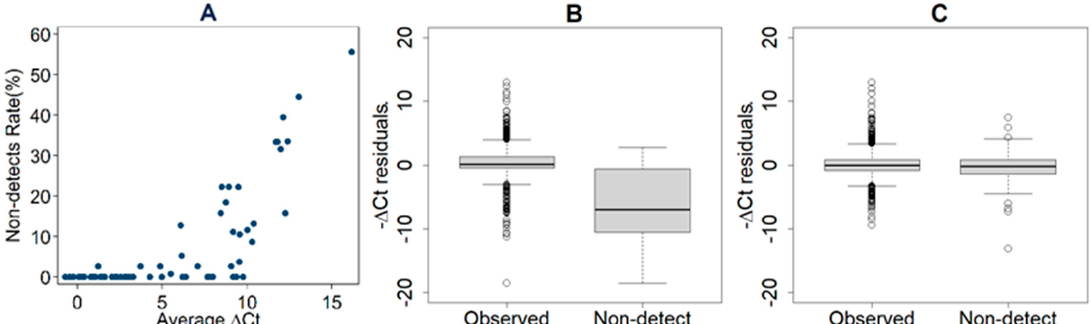
Figure 1. The scatter plot ( A ) indicating that the non-detect rate increases with average ∆ Ct by location, tissue type and gene. The boxplots showing the comparison of − ∆ Ct residues between observed expressions and non-detects, ( B ) if conventional imputation of setting the Ct of each non-detect to 40 was conducted, and ( C ) if expectation-maximization (EM) algorithm was used to estimate the Ct of each non-detect.